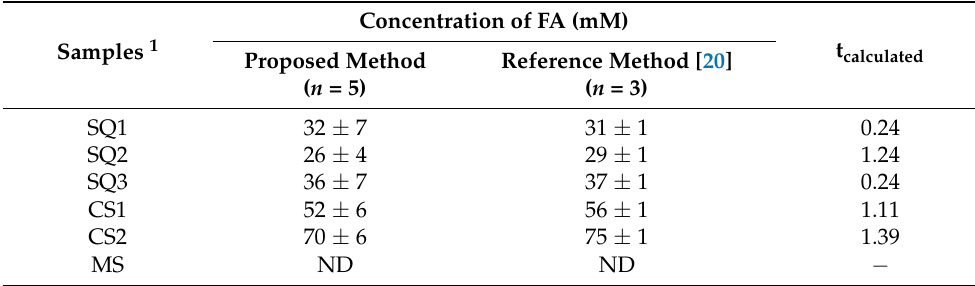
Table 1. Assays of FA contents in